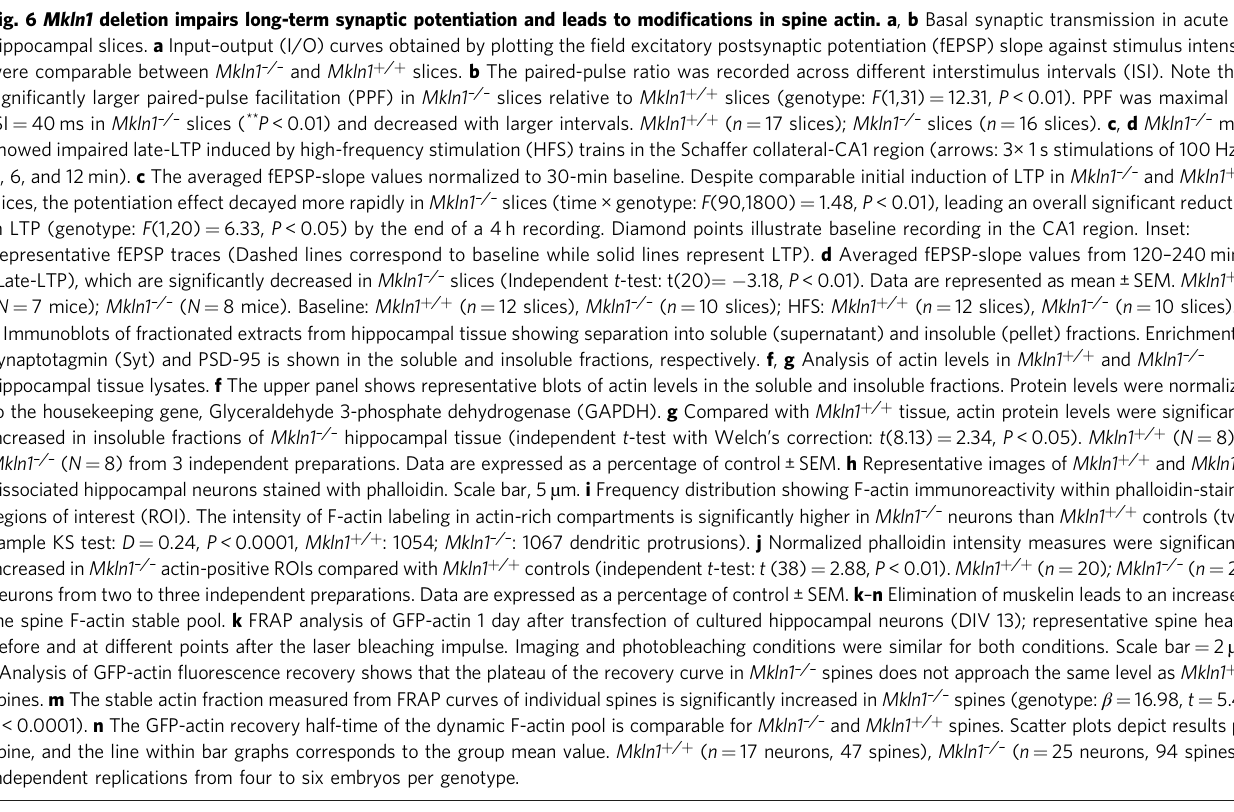
Fig. 6 Mkln1 deletion impairs long-term synaptic potentiation and leads to modi fi cations in spine actin. a , b Basal synaptic transmission in acute hippocampal slices. a Input – output (I/O) curves obtained by plotting the fi eld excitatory postsynaptic potentiation (fEPSP) slope against stimulus intensity were comparable between Mkln1 – / – and Mkln1 + / + slices. b The paired-pulse ratio was recorded across different interstimulus intervals (ISI). Note the signi fi cantly larger paired-pulse facilitation (PPF) in Mkln1 – / – slices relative to Mkln1 + / + slices (genotype: F (1,31) = 12.31, P < 0.01). PPF was maximal at ISI = 40 ms in Mkln1 – / – slices ( ** P < 0.01) and decreased with larger intervals. Mkln1 + / + ( n = 17 slices); Mkln1 – / – slices ( n = 16 slices). c , d Mkln1 – / – mice showed impaired late-LTP induced by high-frequency stimulation (HFS) trains in the Schaffer collateral-CA1 region (arrows: 3× 1 s stimulations of 100 Hz at 0, 6, and 12 min). c The averaged fEPSP-slope values normalized to 30-min baseline. Despite comparable initial induction of LTP in Mkln1 – / – and Mkln1 + / + slices, the potentiation effect decayed more rapidly in Mkln1 – / – slices (time × genotype: F (90,1800) = 1.48, P < 0.01), leading an overall signi fi cant reduction in LTP (genotype: F (1,20) = 6.33, P < 0.05) by the end of a 4 h recording. Diamond points illustrate baseline recording in the CA1 region. Inset: Representative fEPSP traces (Dashed lines correspond to baseline while solid lines represent LTP). d Averaged fEPSP-slope values from 120 – 240 min (Late-LTP), which are signi fi cantly decreased in Mkln1 – / – slices (Independent t -test: t(20) = − 3.18, P < 0.01). Data are represented as mean±SEM. Mkln1 + /